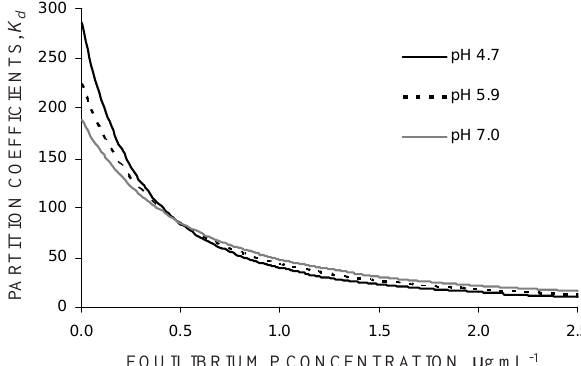
Figure 2. Partition coefficients relative to equilibrium P concentration for P sorption isotherms at three different soil pH levels.